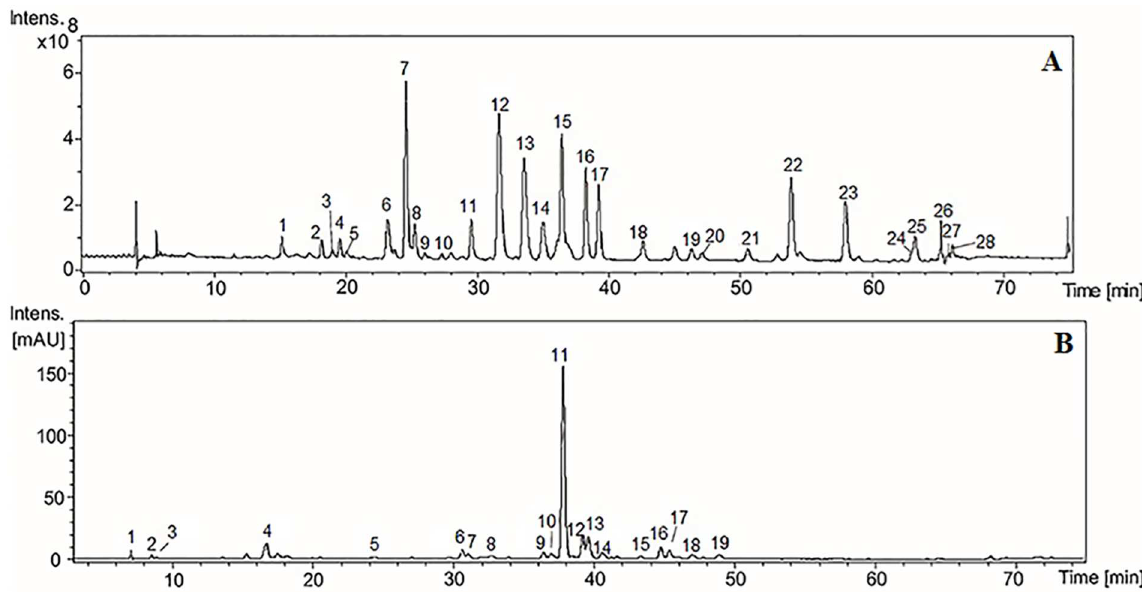
Fig 1. HPLC-DAD-MS chromatograms of K . brasiliensis (A) and K . pinnata (B) HE extracts. The extracts were chromatographedon a Phenomenex RP-18 column (250 x 4.6 mm, 5 um) and the column was eluted with a gradientof acetonitrile (ACN) in 3% acetic acid at a flow rate of 0.7 mL/min. The elution profile was monitored at 340 nm. Peaks 6–8, 11–17, 22 and 23 were considered to be major peaks in panel A, and peaks 4 and 11–13were considered to be major peaks in panel